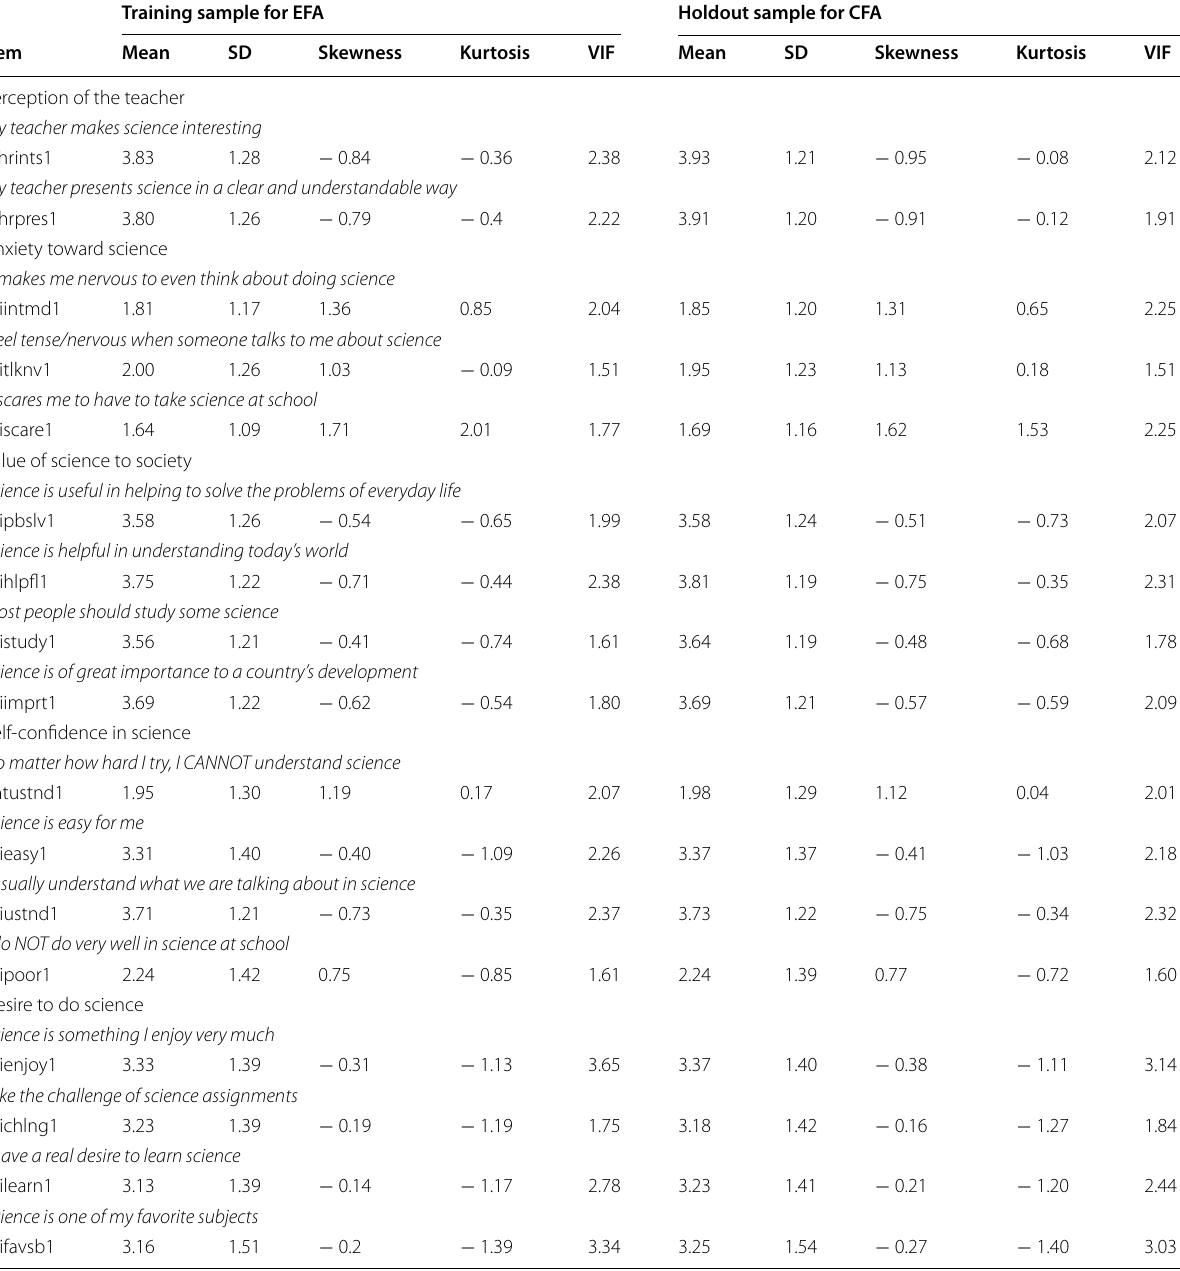
Table 3 First sampling wave: descriptive statistics of mATSI:2 attitude items in Fall 2012 Training sample for EFA Holdout sample for